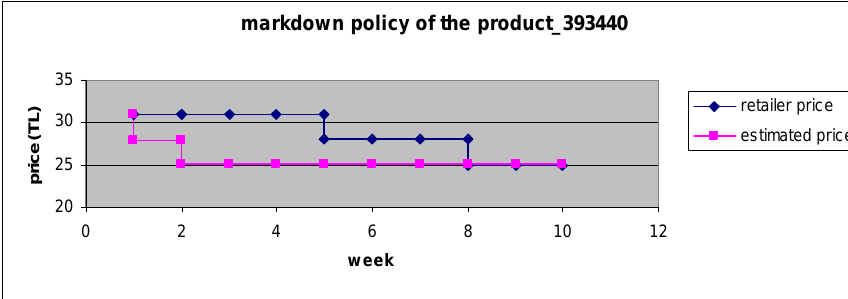
Fig. 9. Comparison between the retailer and estimated